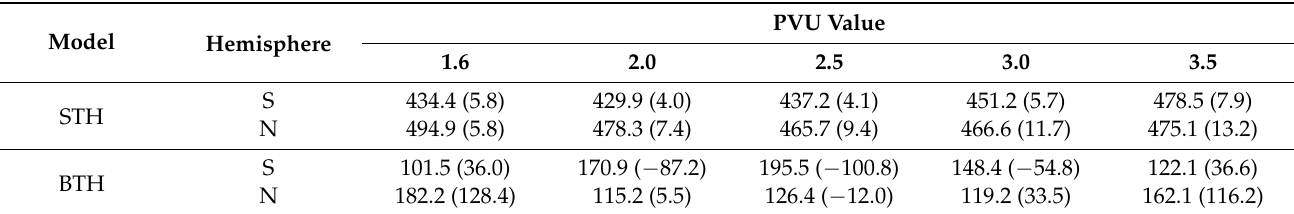
Figure 6. Left panel top: tropopause computed using the STH model (red lines) for SH and the 3.5 PVU coefficients; the black dashed lines represent the ERA5-derived tropopause annual fluctuation; Left panel bottom: as above, for NH; Right panel: tables needed to apply the BTH model. Table 4. Mean Root-mean-square error (RMSE) and bias values of the STH and BTH model fit, respectively, for each PVU value and hemispheres (in m). Values in parentheses identify the bias. A positive bias indicates a model